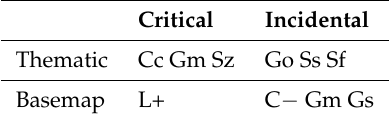
Figure 3. Richard Edes Harrison’s 1941 map about the geopolitical situation of the USA at the outset of WWII. Colors and hatching are used to classify nations according to the cartographer’s idea of how well they align to US policy, while solid or dashed lines represent economic relationships to other countries. The goal of the map is to suggest that the economic relationship “routes” are threatened if regions they pass through become occupied by powers who oppose US policy, such as by the Axis. Table 4. Schedule of operators for Harrison’s The World